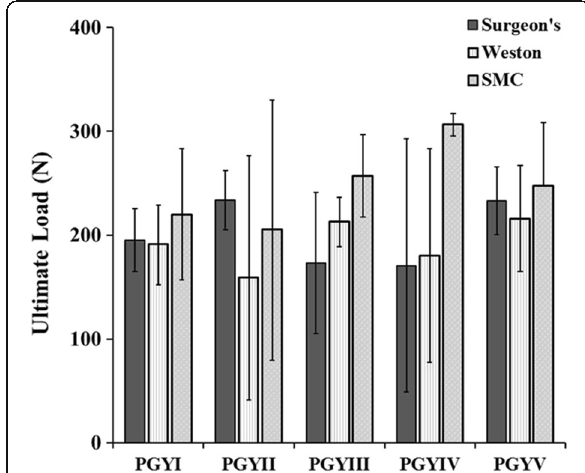
Fig. 3 Ultimate Load to Failure. Ultimate failure load as a function of resident training for the surgeon ’ s, Weston and SMC knots. Results indicate no significant difference in ultimate failure load for each knot as a function of resident education level ( p >